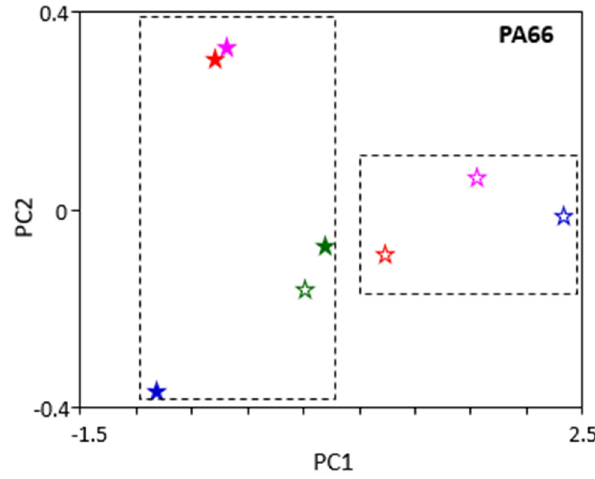
Figure 8. PCA analysis of the FT-IR spectra of the PA66 (oil A (blue), oil B (green), oil C (fuchsia), oil D (red), 672 h (empty markers) and 168 h (solid markers)).